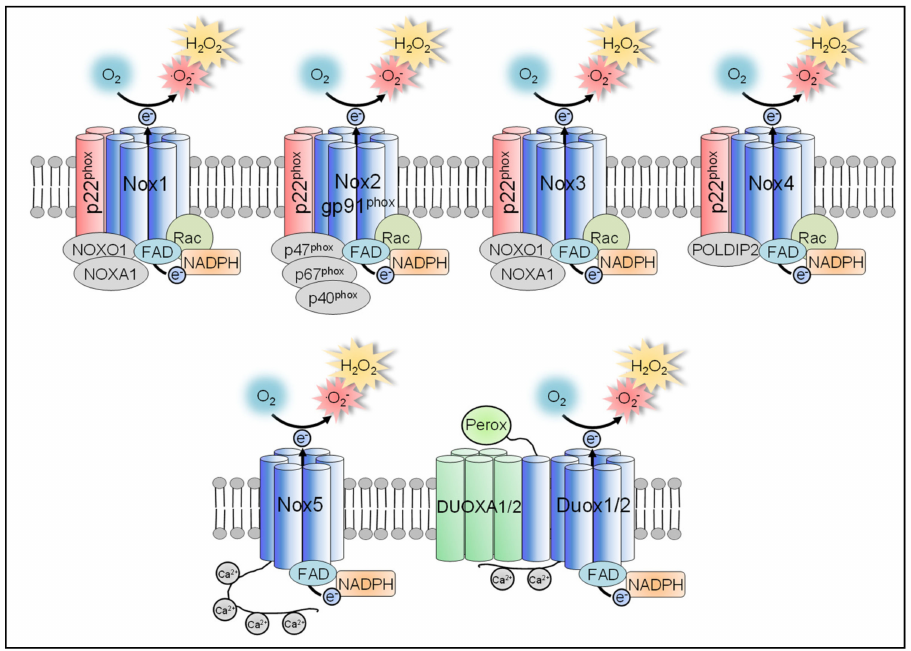
Figure 3. The enzyme family of NADPH oxidases consists of Nox1, Nox2, Nox3, Nox4, Nox5, and the dual oxidases Duox1 and Duox2. Different stimuli can trigger ROS production by Nox1, 2 and 3, whereas Nox4 is considered to be constitutively active. Nox5, Duox1 and Duox2 are activated by calcium binding through their cytosolic EF-hand calcium binding